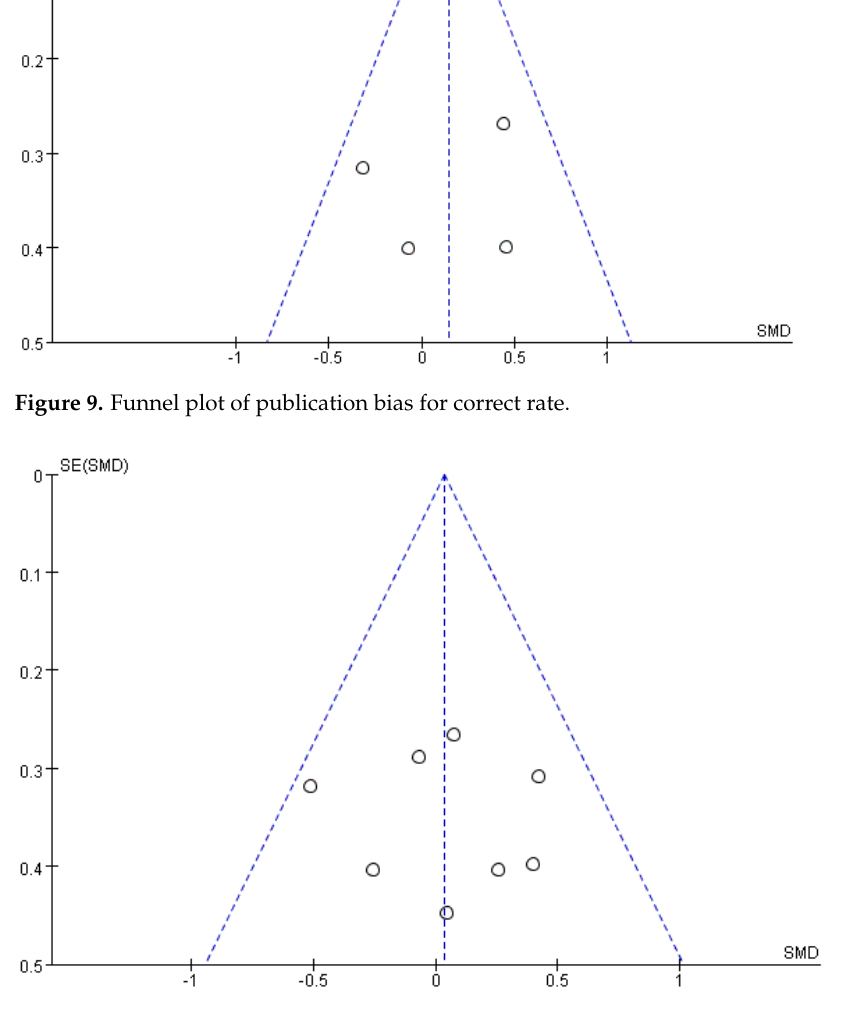
Figure 10. Funnel plot of publication bias for response time.